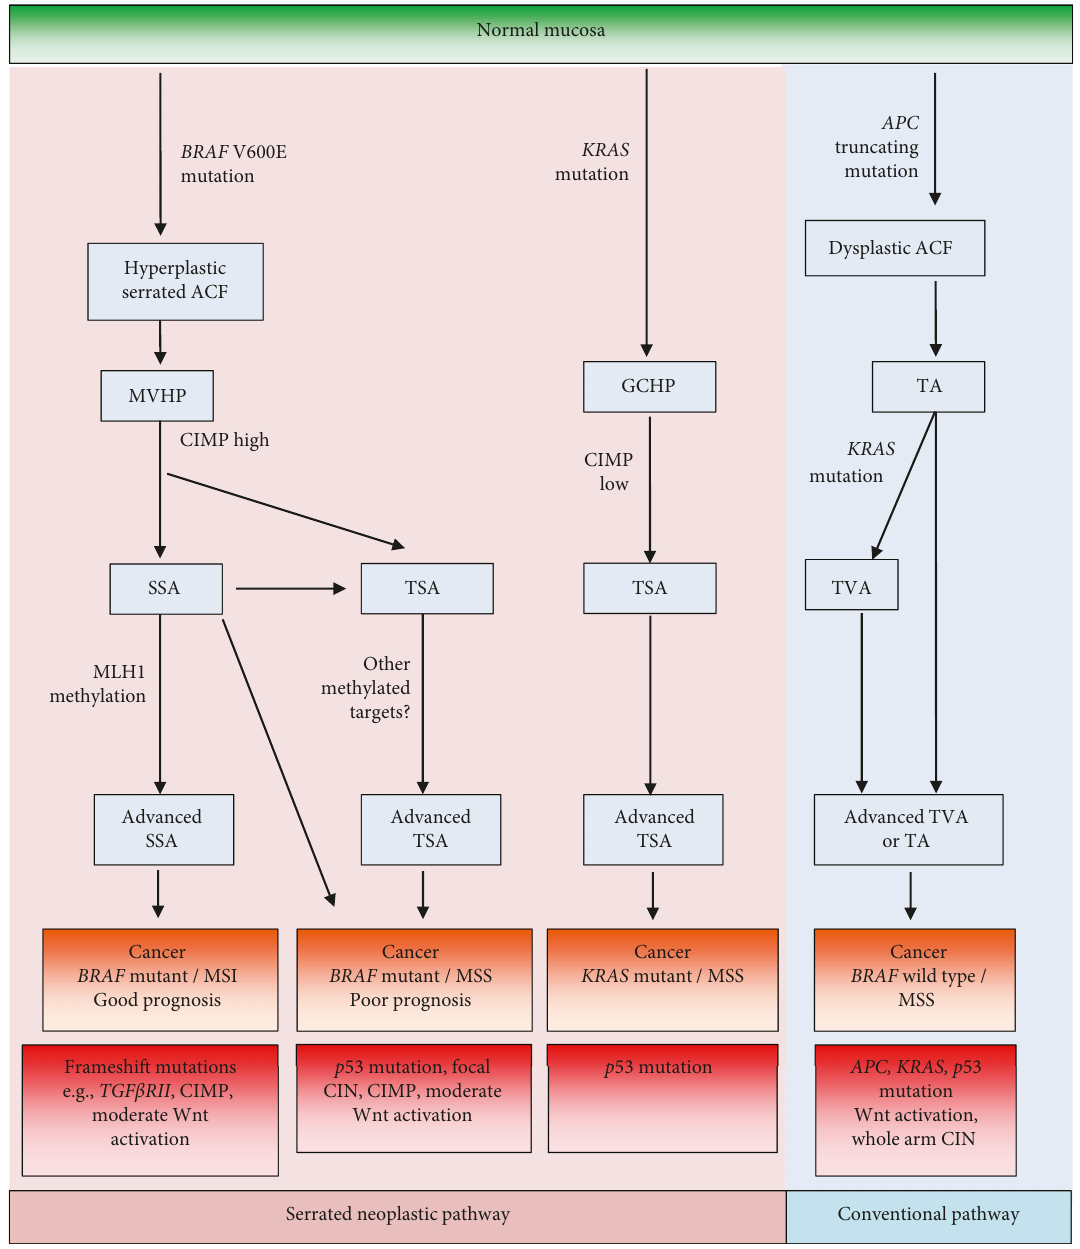
Figure 2: Diagram of the serrated and conventional pathways of colorectal cancer. Bold text indicates the pathways leading to BRAF mutant cancers. ACF: aberrant crypt foci; GCHP: goblet cell hyperplastic polyp; MVHP: microvesicular hyperplastic polyp; SSA: sessile serrated adenoma; TSA: traditional serrated adenoma; TA: tubular adenoma; TVA: tubulovillous